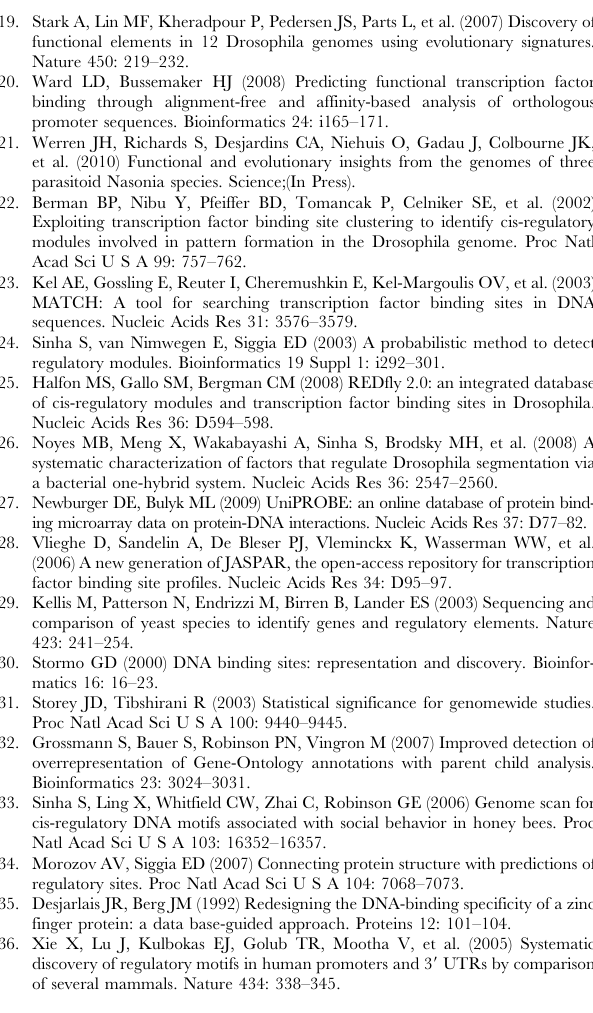
Table S5 Motif associations with genes up-regulated in response to Manganese treatment in honeybees.